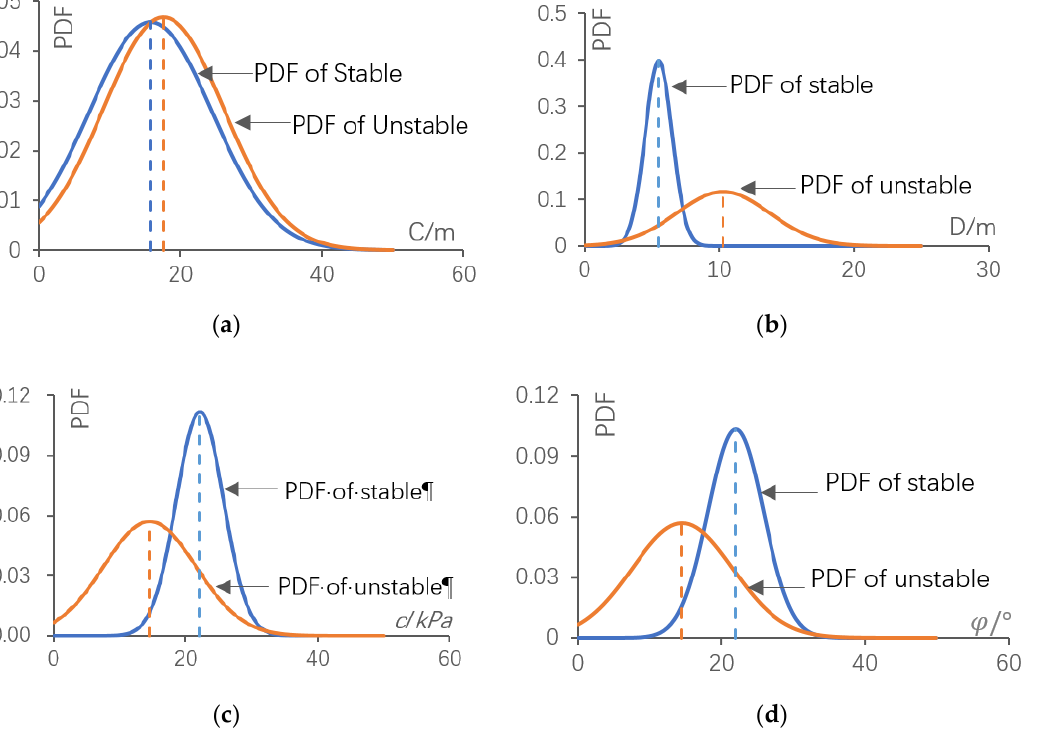
Figure 5. PDF of parameters for stable and unstable samples: ( a ) the cover depth; ( b ) the diameter; ( c ) the cohesive strength; ( d ) the friction angle.